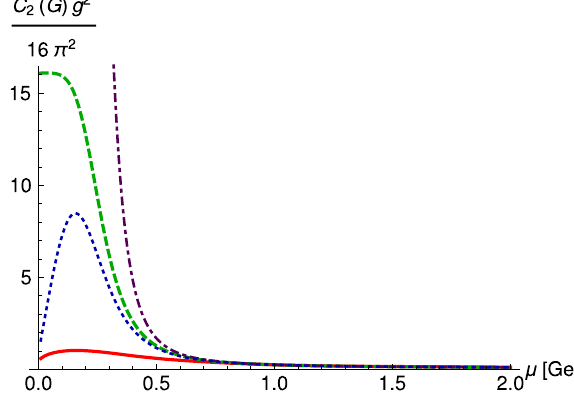
Fig. 3 Running coupling constant for the four-dimensional massive Yang–Mills model: Landau pole (purple dot-dash line), scaling solution (green broken line), decoupling solution (blue dotted line), physical point (red solid line) from top to